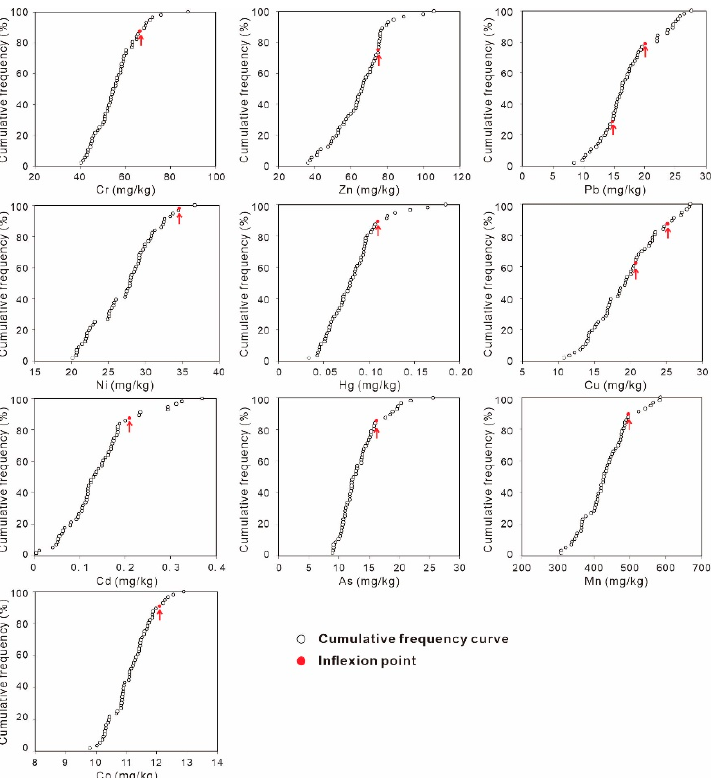
Figure 4. Relative cumulative frequency curves of HMs in the soils of study area.